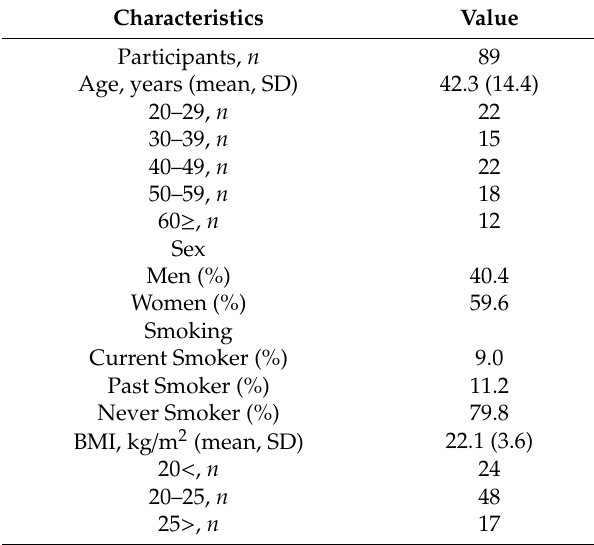
Table 1. Baseline characteristic of study